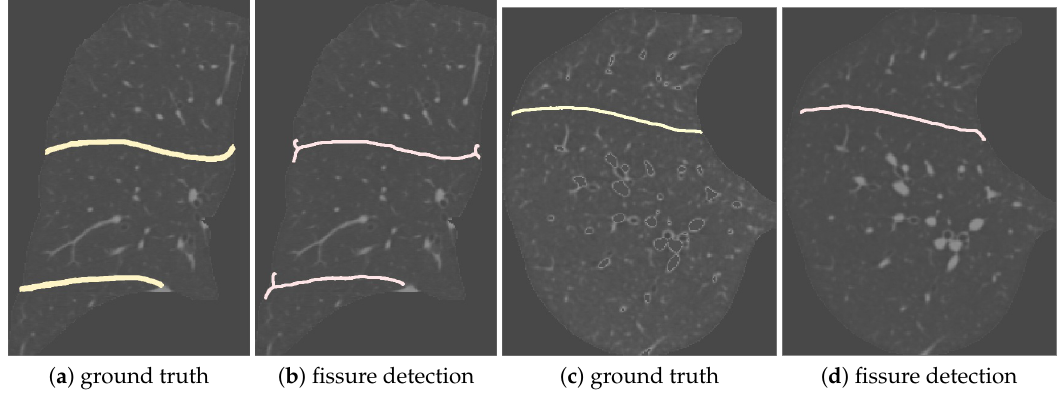
Figure 6. Visual illustration of the fissure detection results in lung CT images. ( a ) Ground truth and ( b ) fissure detection for the coronal plane. ( c ) Ground truth and ( d ) fissure detection for the axial